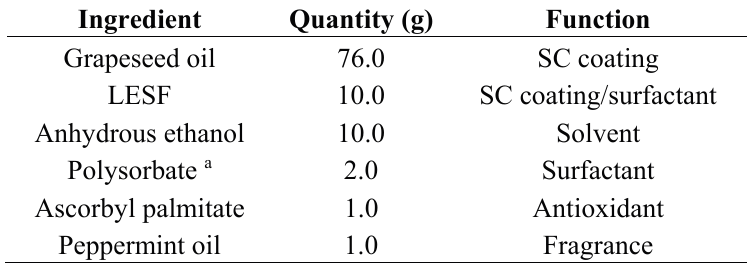
Table 1. Composition of oiling bath preparation (SC, stratum corneum; LESF, rapeseed lecithin ethanol soluble